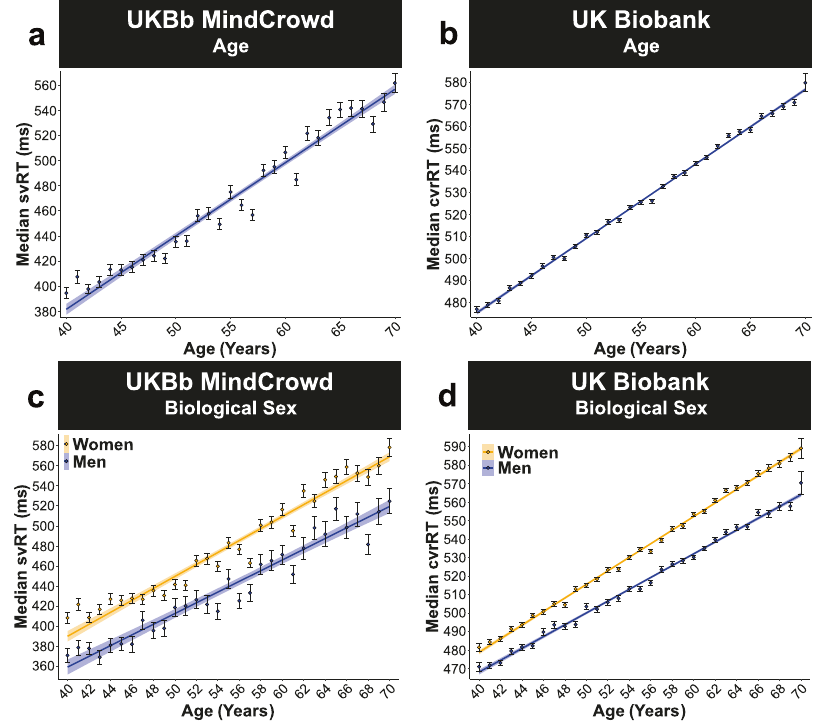
Fig. 4 UK Biobank: age and biological sex. UKBb MindCrowd and UK Biobank analysis (ages 40 – 70) of visual reaction time (RT). a – b Age was linearly associated with RT. a UKBb MindCrowd linear model fi ts (line fi ll ±95% CI, error bars ± SEM) of median simple visual RT (svRT) from young to old Age. b UK Biobank linear model fi ts (line fi ll ±95% CI, error bars ± SEM) of median complex visual recognition RT (cvrRT) from young to old Age. UKBb MindCrowd svRT ( β Age = 5.75, p Age = 2.00E − 16, n = 39,795) and UK Biobank cvrRT ( β Age = 3.40, p Age = 2.00E − 16 , n = 158,245) were associated with similar lengthening from younger to older ages. The average 50 ms difference between UKBb MindCrowd svRT ( M = 478.66 ms) and UK Biobank ( M = 528.74 ms) is due to the choice component (i.e., do cards match or not > press button) of the UK Biobank ’ s cvrRT task compared to UKBb MindCrowd ’ s stimulus-response (i.e., the pink sphere appears > press button) svRT. c – d Being a man, as compared to being a woman, was associated with shorter visual RT. c UKBb MindCrowd linear model fi ts (line fi ll ±95% CI, error bars ± SEM) of median svRT from young to old Age with lines split by Biological Sex. d UK Biobank linear model fi ts (line fi ll ±95% CI, error bars ± SEM) of median cvrRT from young to old Age with lines split by Biological Sex. Both UKBb MindCrowd svRT ( β Sex = − 40.00, p Sex = 8.03E − 71, 20.46%, Women [ M = 489.75 ms, n = 29,640], Men [ M = 446.28 ms, n = 10,155]) and UK Biobank cvrRT ( β Sex = − 18.28, p Sex = 2.00E − 16, 5.16%, Women [ M = 534.98 ms , n = 89,331], Men [520.66 ms , n = 68,914) found that being a man was consistently associated with shorter RT when compared to being a woman from 40 – 70 years of